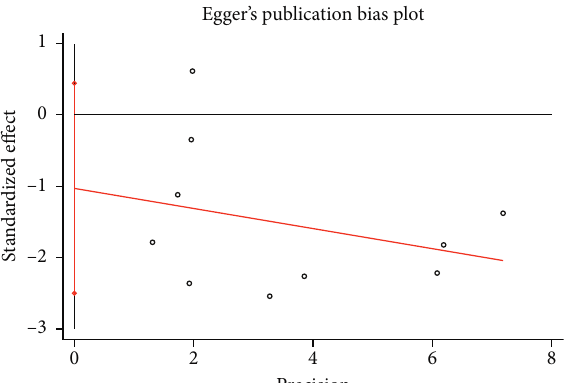
Figure 8: Comparison of PMI between the experimental group and the control group (Egger’s test). RR � risk ratio; PMI � periprocedural myocardial